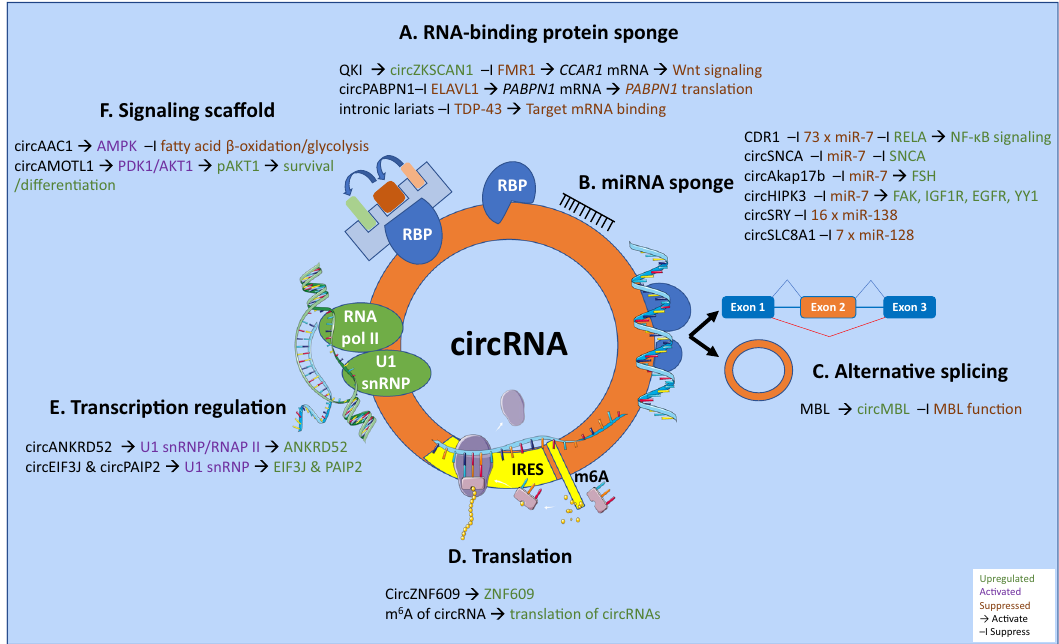
Fig. 2 Regulatory functions of circRNAs. CircRNAs function as sponges for RNA binding proteins ( A ) and miRNAs ( B ) to regulate mRNA expression. They also compete with canonical pre-mRNA splicing to induce alternative splicing ( C ). Harboring an IRES motif or by enhanced N 6 methylation of adenosine residues, they are translated into proteins or peptides ( D ). They directly interact with RNA pol II and U1 snRNP to regulate transcription ( E ), and they function as protein scaffolds for intracellular signaling ( F ). Some elements in this image were obtained from Servier Medical Art (http://smart.servier.com/), permissible to use under a Creative Commons Attribution 3.0 Unported